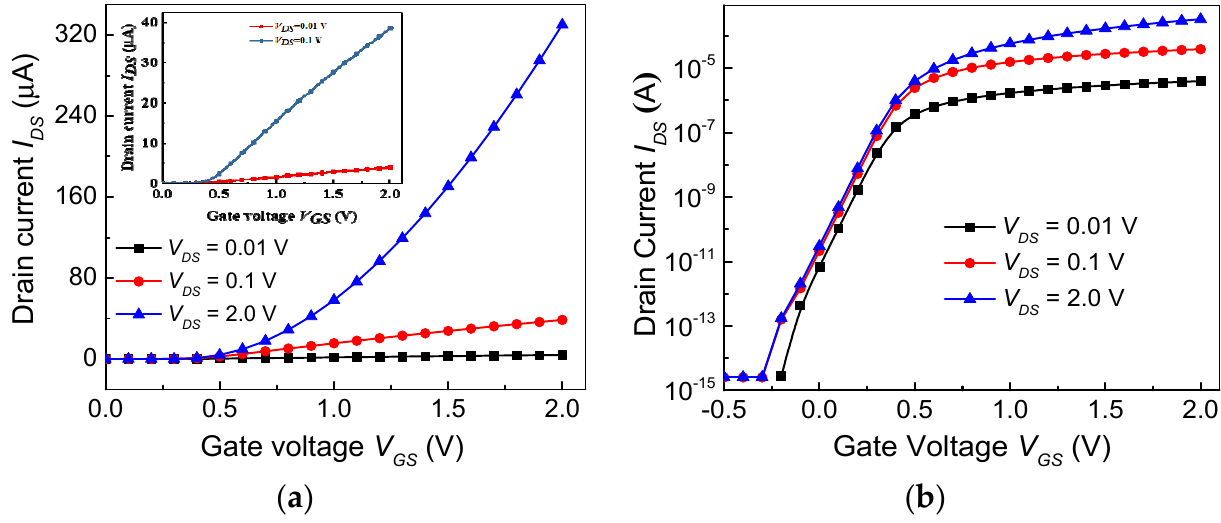
Figure 6. ( a ) I DS – V GS characteristic of the proposed vertical MOSFET; ( b ) transfer characteristic curve of the proposed vertical MOSFET.